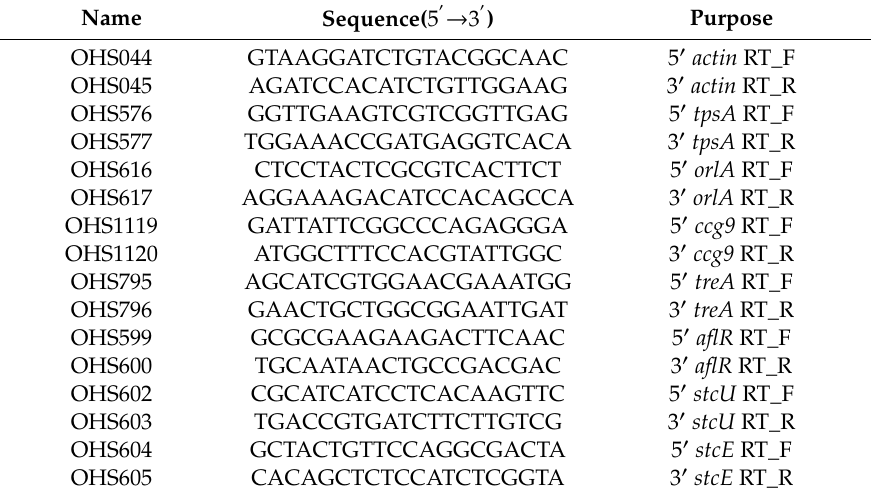
Table 1. Oligonucleotides used in this